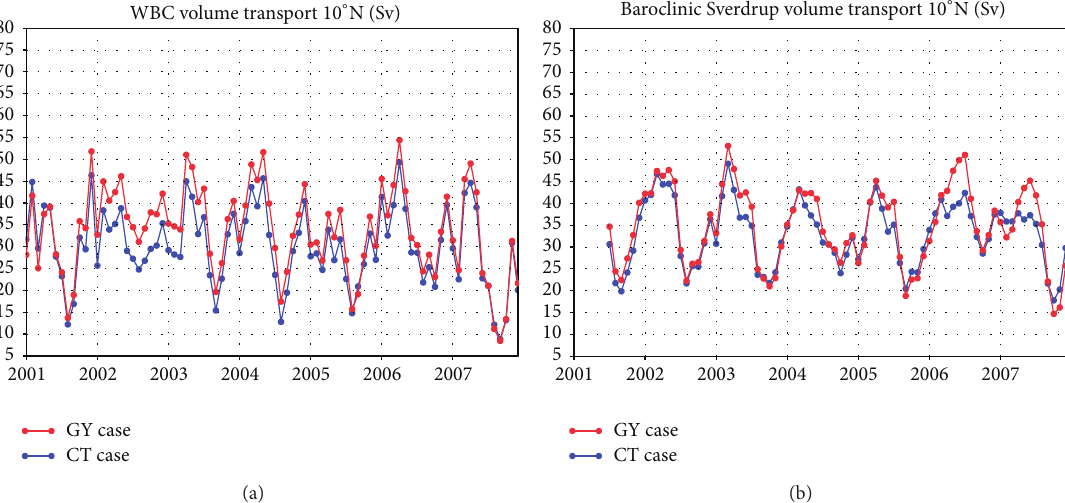
Figure 8: Time series of (a) the estimated southward volume transport (in sverdrups) of the western boundary current across 10 ∘ N and (b) the northward “baroclinic” Sverdrup volume transport at 10 ∘ N